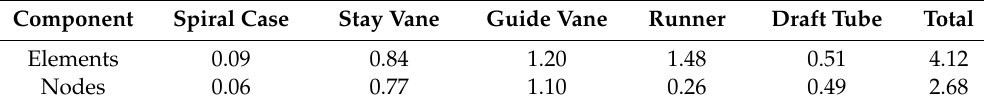
Figure 2. Grid number sensitivity analysis (18 deg GVO). Table 1. Number of grids (million).